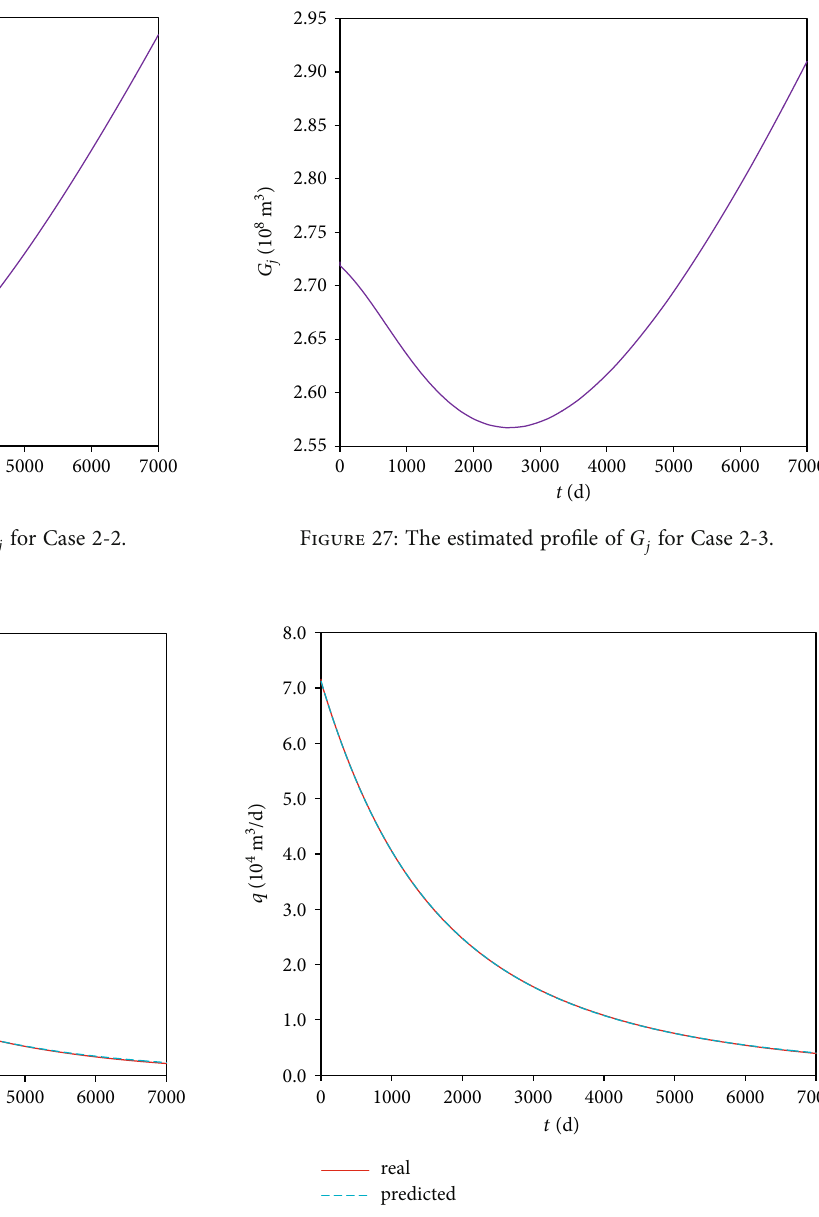
Figure 26: The real q pro fi le and the predicted pro fi le by the hyperbolic decline model for Case 2-3.